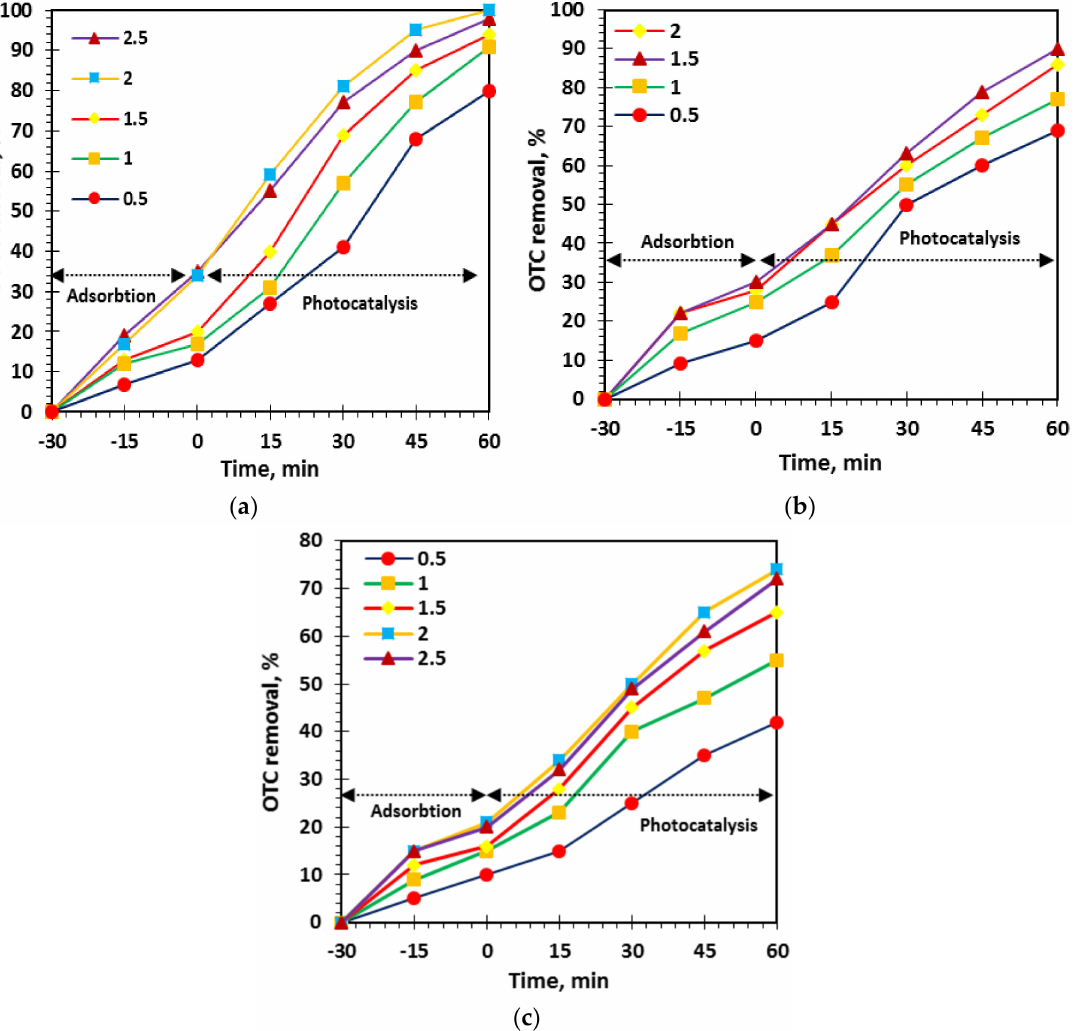
Figure 1. Effect of the amount of dopant agents in L − Amino acid − TiO 2 composites on OTC photo- catalytic removal, ( a ) L − Histidine, ( b ) L − Methionine and ( c ) L − Asparagine at catalyst loading of 1 g/L, OTC concentration of 50 mg/L and original pH